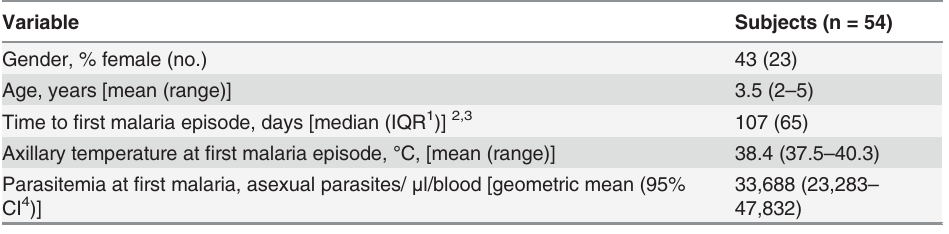
Table 1. Demographic and clinical characteristics of study